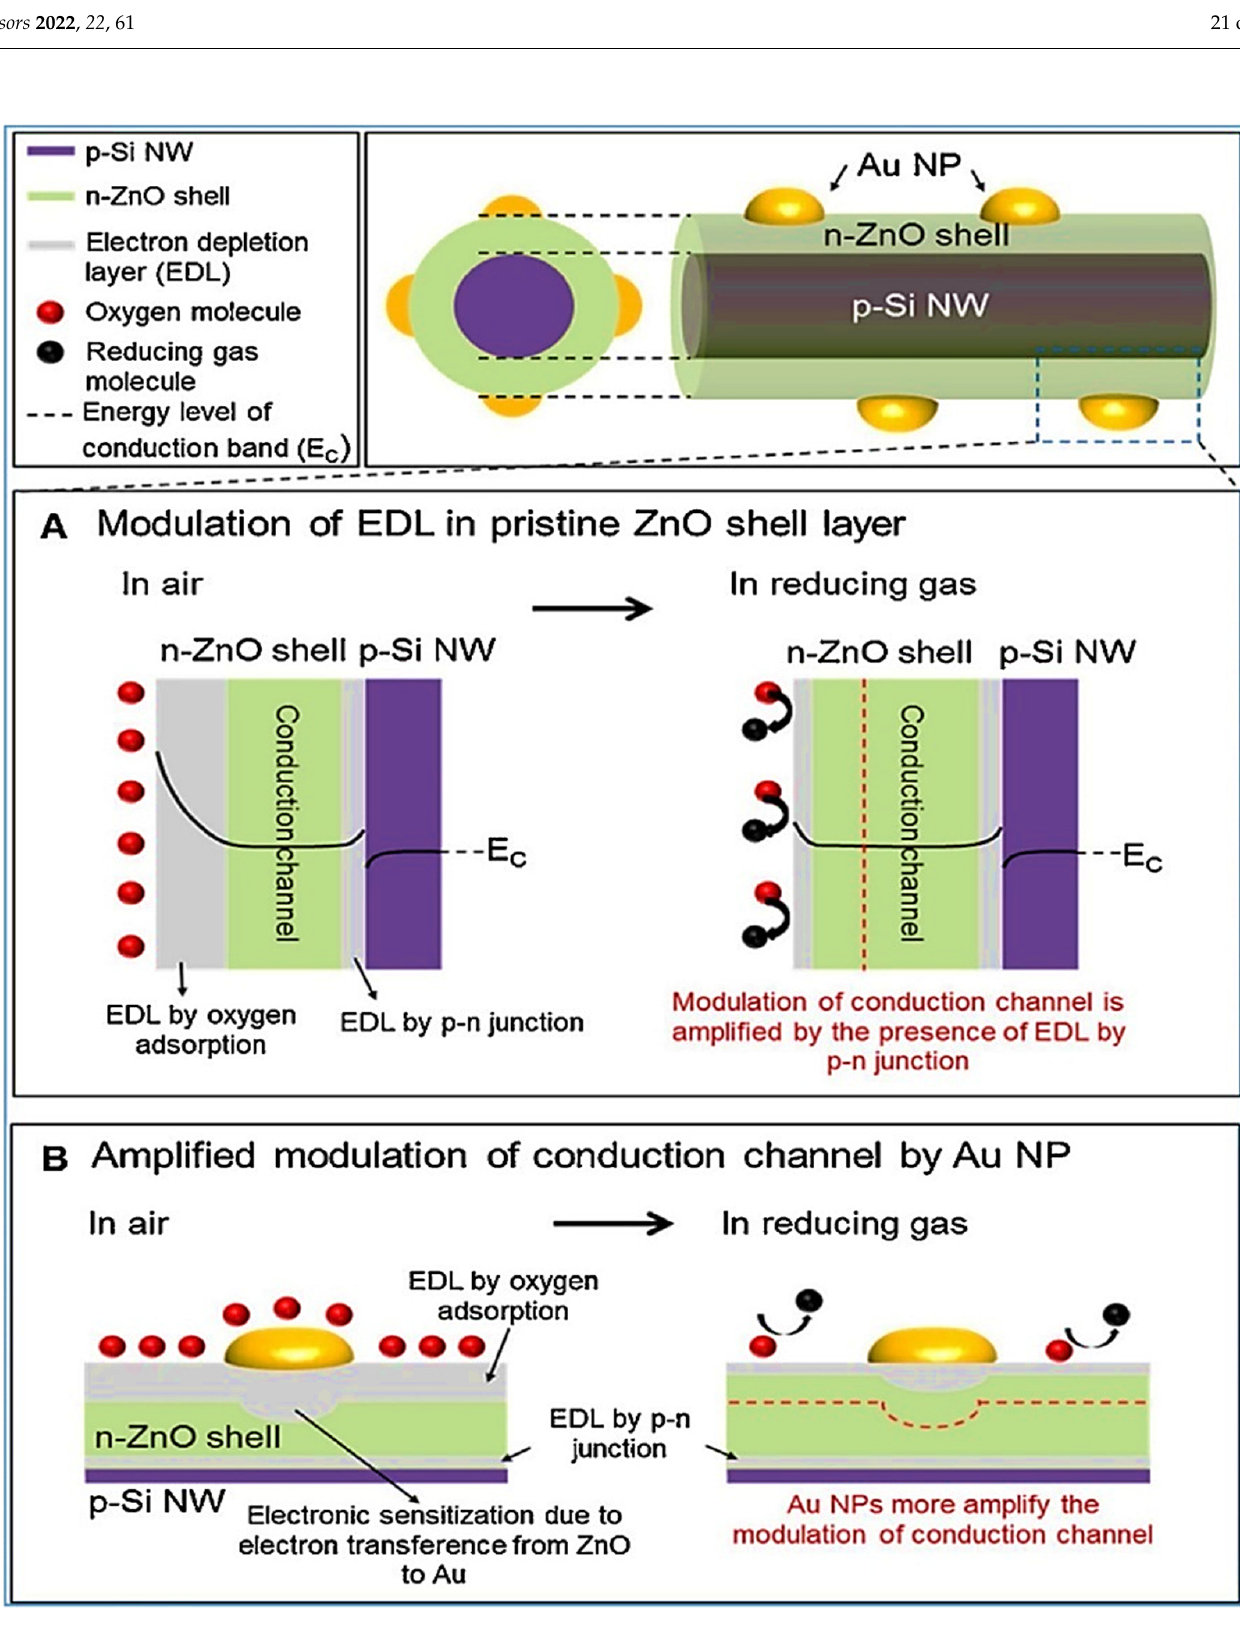
Figure 11. Schematic of the sensing mechanism in the Au-decorated Si NWs/ZnO C-S sensor; ( A ) depletion layers in pure Si NWs/ZnO C-S layer, and ( B ) expansion of electron depletion layer in the presence of Au. Reproduced from [84] with the permission of Elsevier.